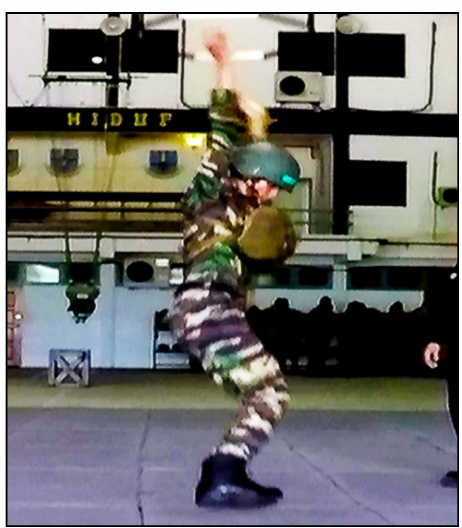
Figure 2. Position of the subject on the sagittal plane.